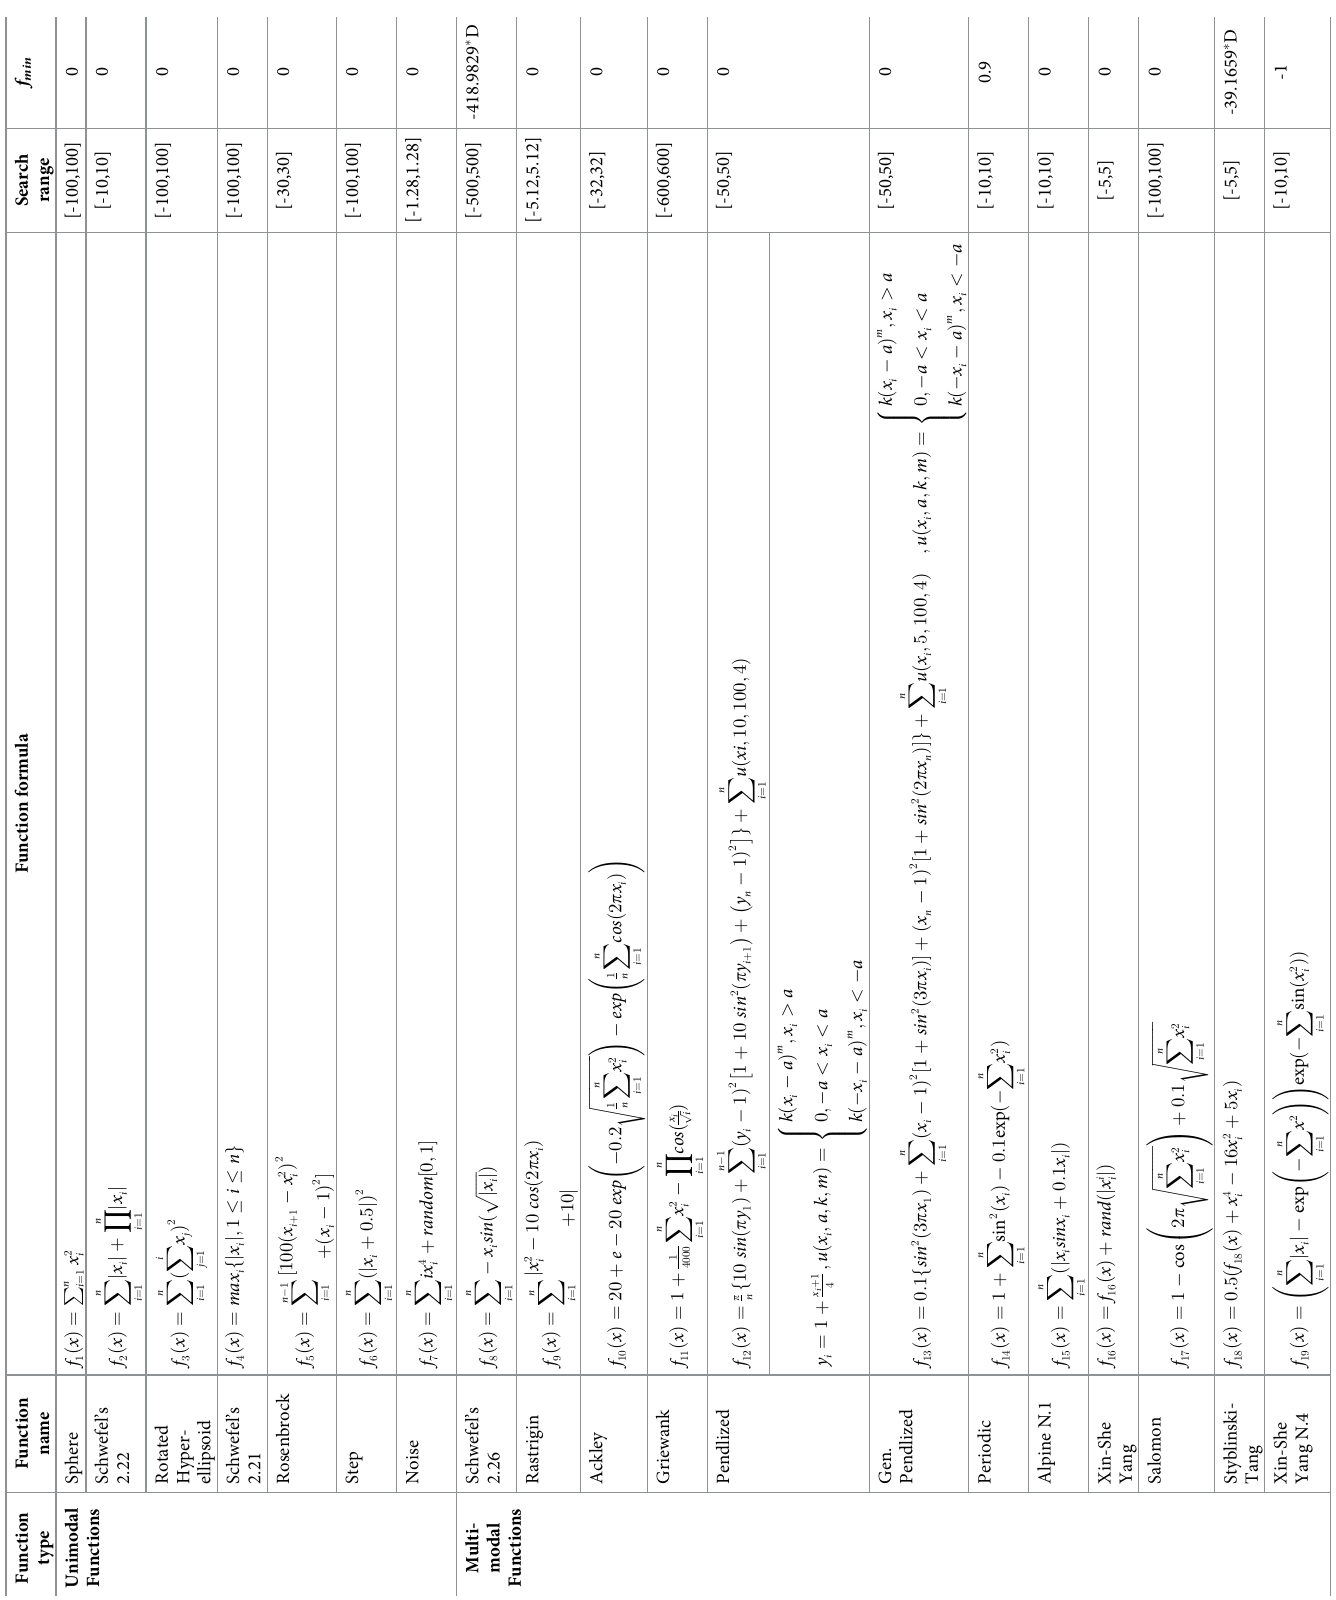
ffiffiffiffi X ffiffiffiffiffiffi ffi